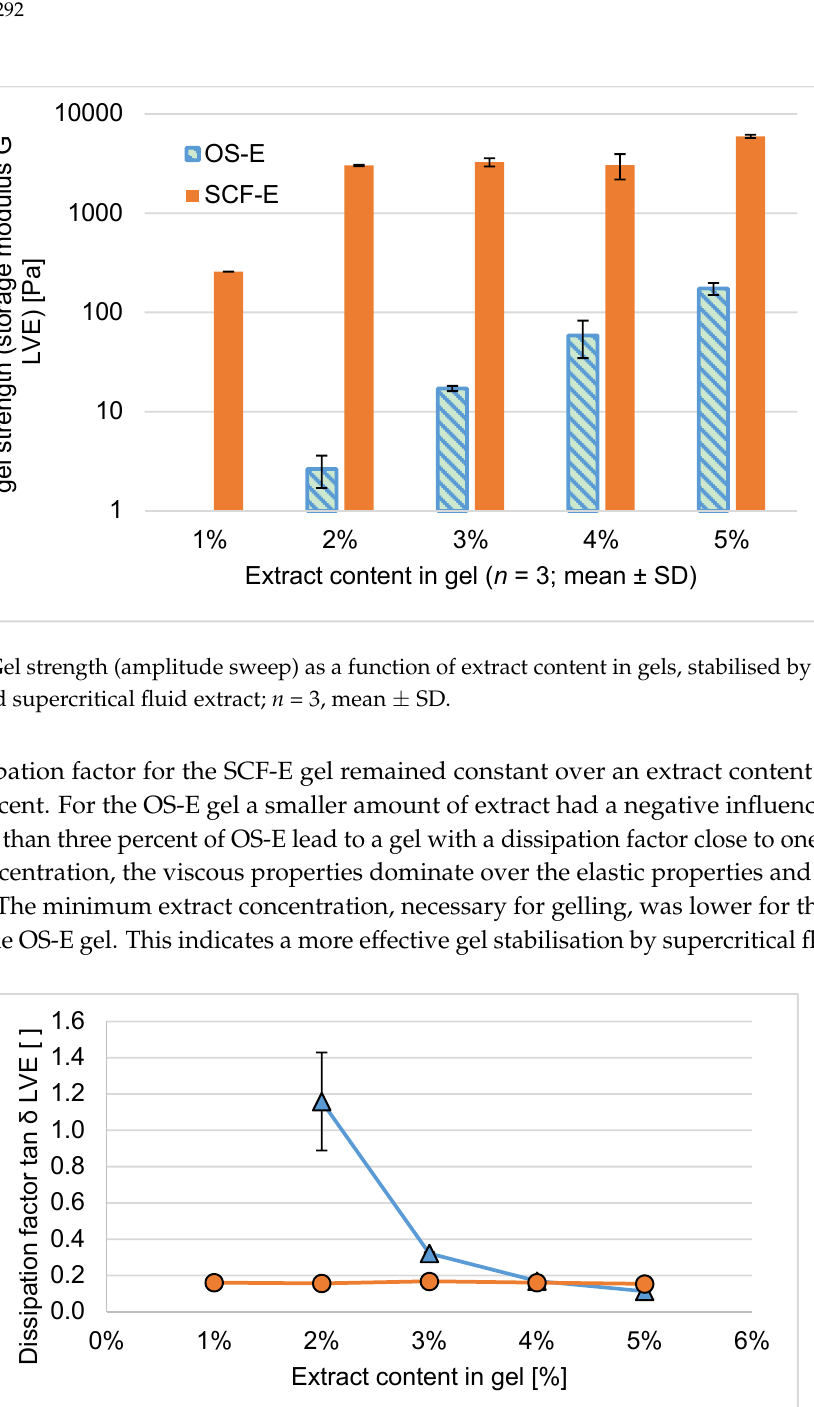
Figure 10. Dissipation factor (amplitude sweep) as a function of extract content in gels, stabilised by organic solvent and supercritical fluid extract; mean ± SD.